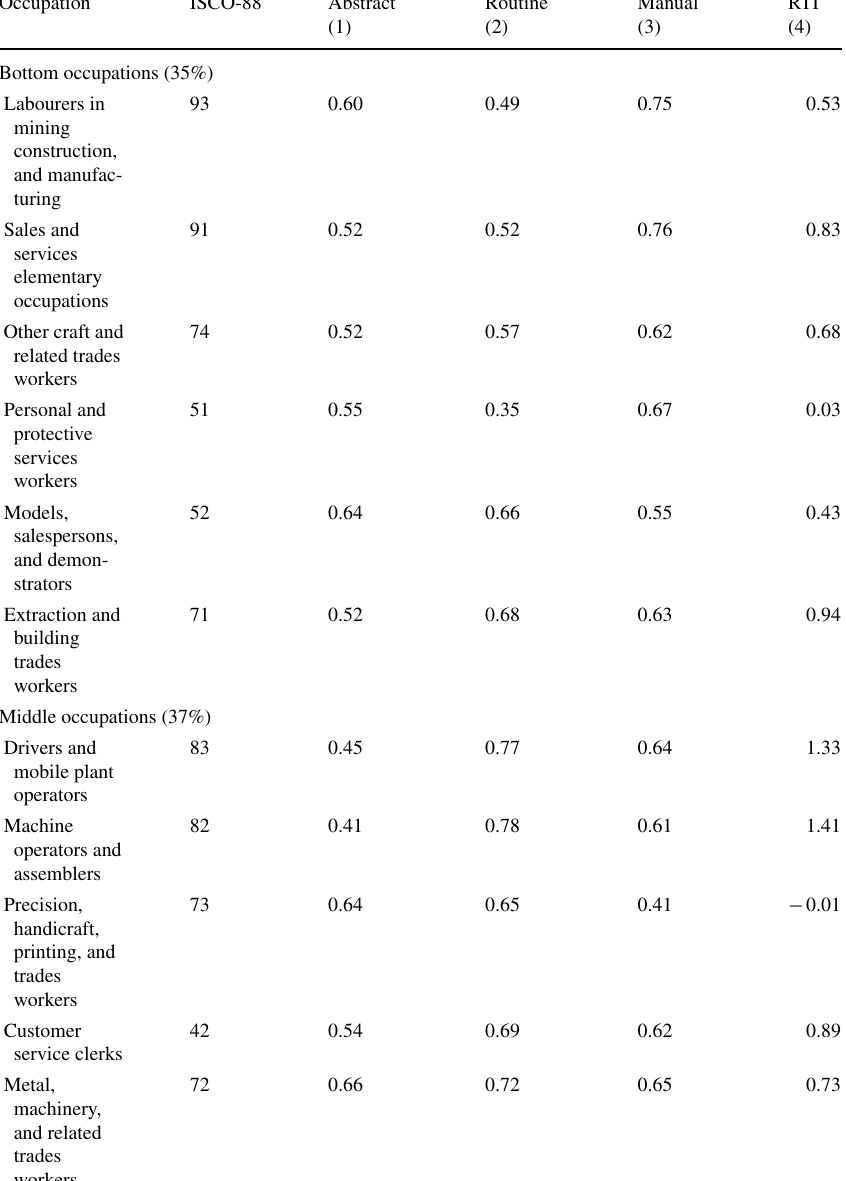
Table 6 Tasks measures by occupations. Sources : author’s analysis from the Spanish Labour Force Survey and the European Working Condition Survey